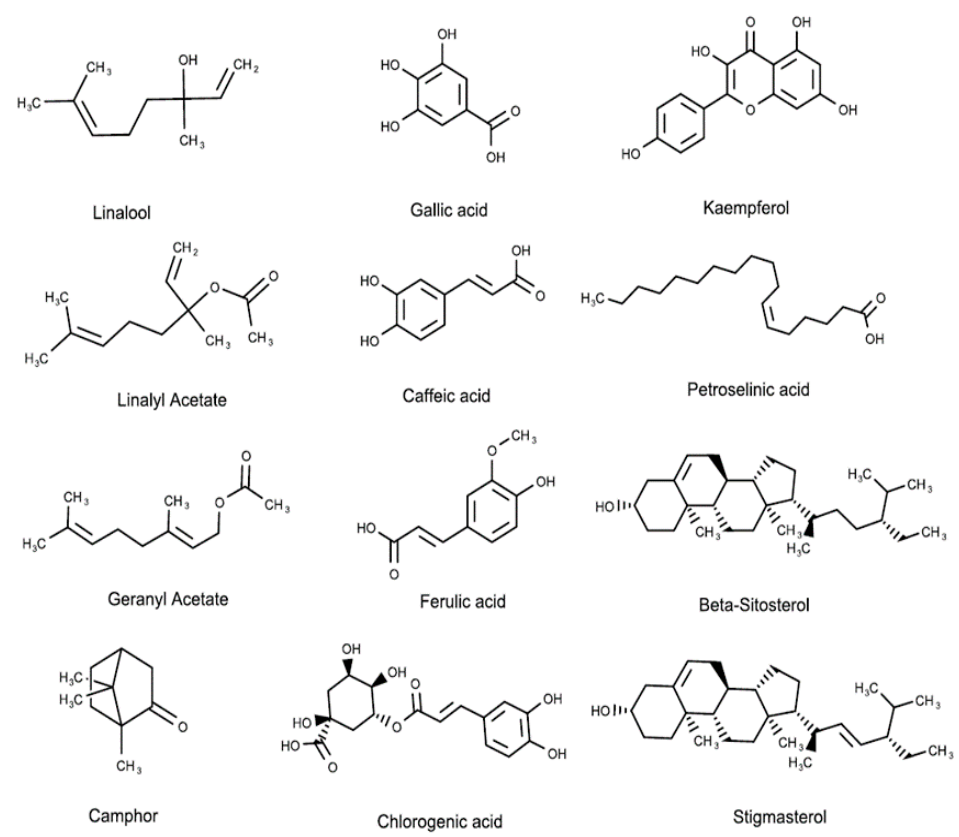
Figure 3. Phytochemical molecular structures extracted from C. sativum , such as terpenes, phenolic acids, flavonoids, fatty acids, and phytosterols.